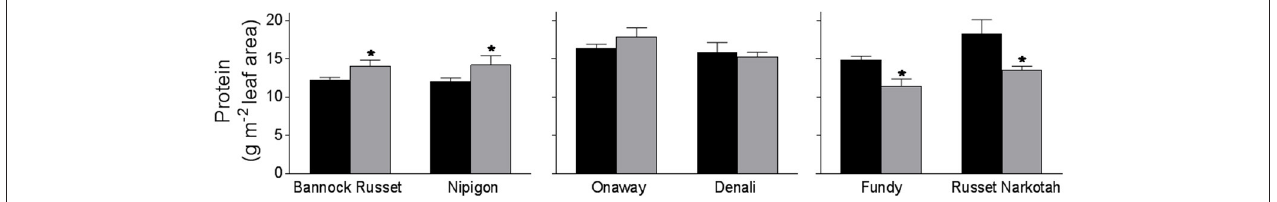
FIGURE 4 | Leaf protein content of six potato genotypes grown under well-watered and drought conditions. Leaf protein content was estimated on the fully expanded terminal leaflets of 5-week-old well-watered plants or drought-stressed plants (analyzed after 6 days of withholding watering). The data represent the averages of three experiments ± SE. Significant differences of the means between well-watered and drought-stressed plants within each cultivar are indicated by the symbol * ( P ≤ 0.05).